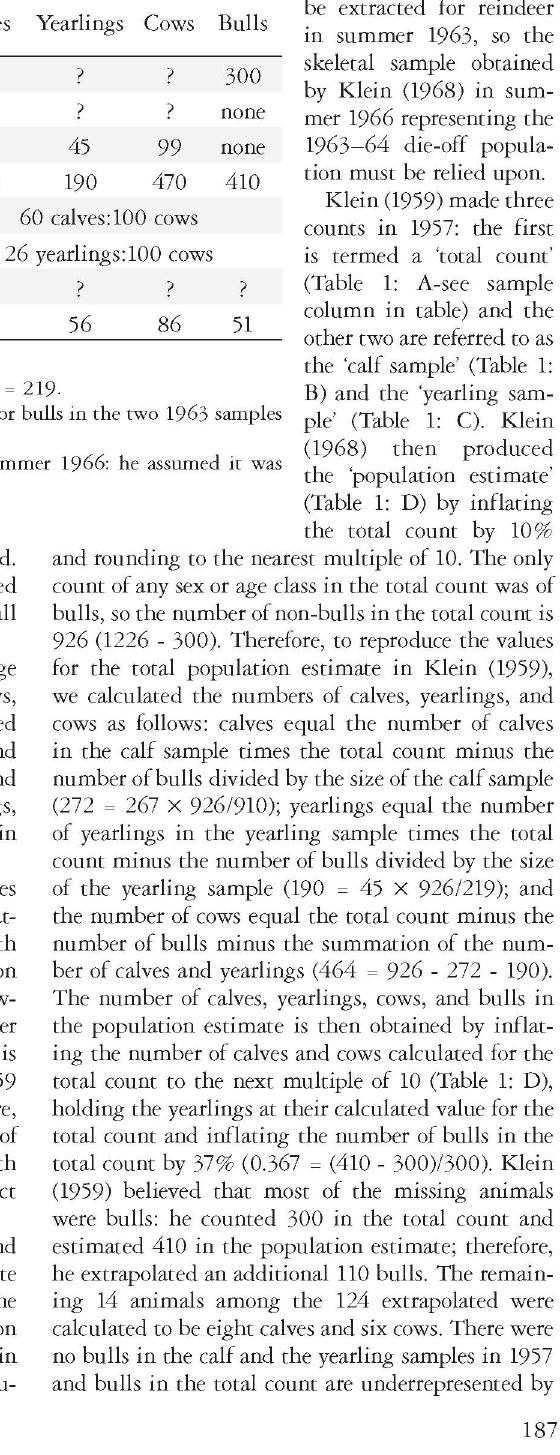
Table 1. Total quantitative data available from Klein (1959, 1968) for determining the size and sex and age composition of the St. Matthew Island reindeer population in 1957 and